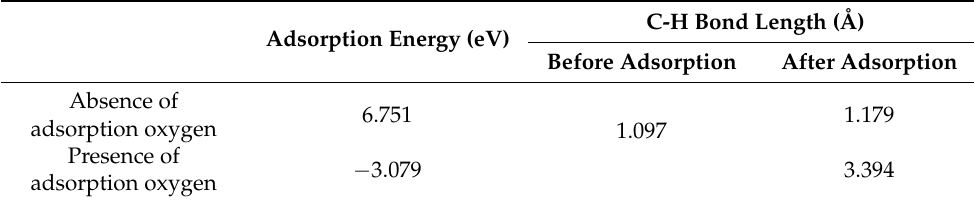
Table 4. Comparison of adsorption and activation abilities of methane molecules on the In 2 O 3 (110) surface (with oxygen vacancies) in the presence or absence of adsorbed oxygen.